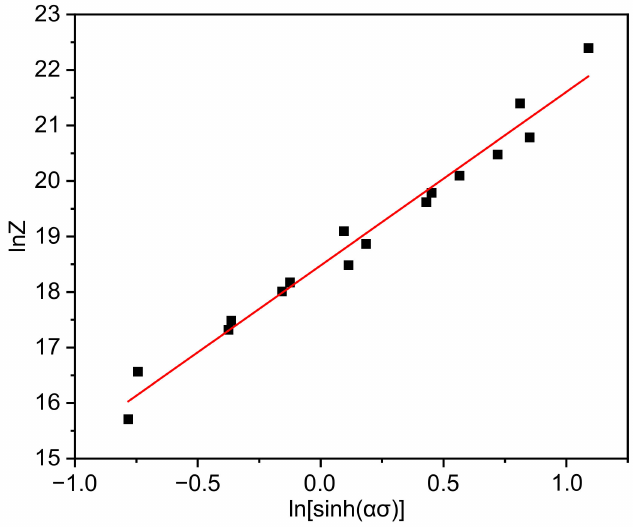
Figure 6. Relationship diagram of thermal deformation parameters lnZ and ln [ sinh ( ασ )] . According to its intercept, we can get lnA = 18.48, A = 1.06 × 10 8